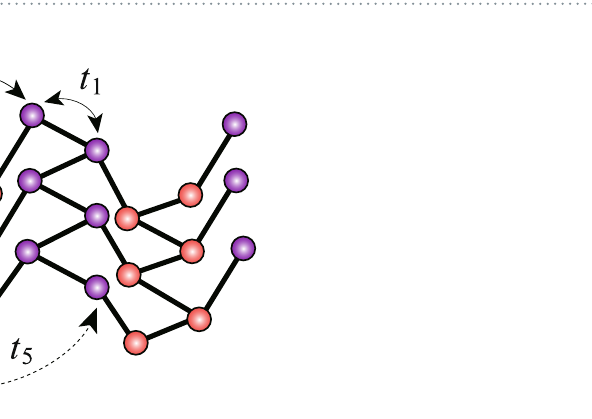
Figure 2. Schematic representation of the hopping integrals involved in the present TB